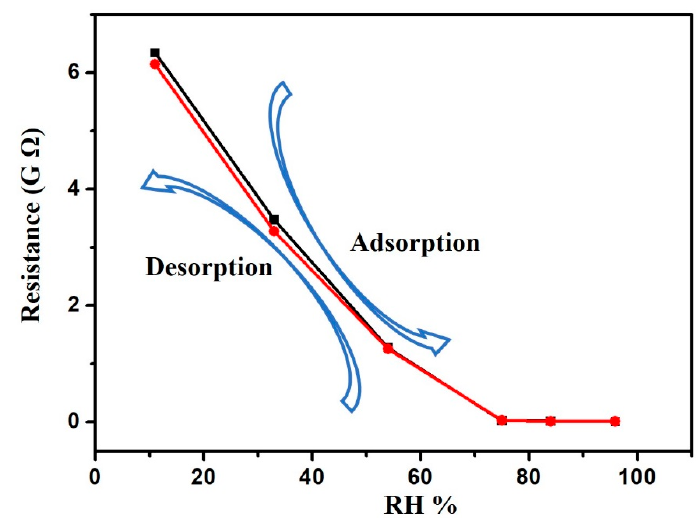
Figure 7. The hysteresis curve showing adsorption/desorption responses.